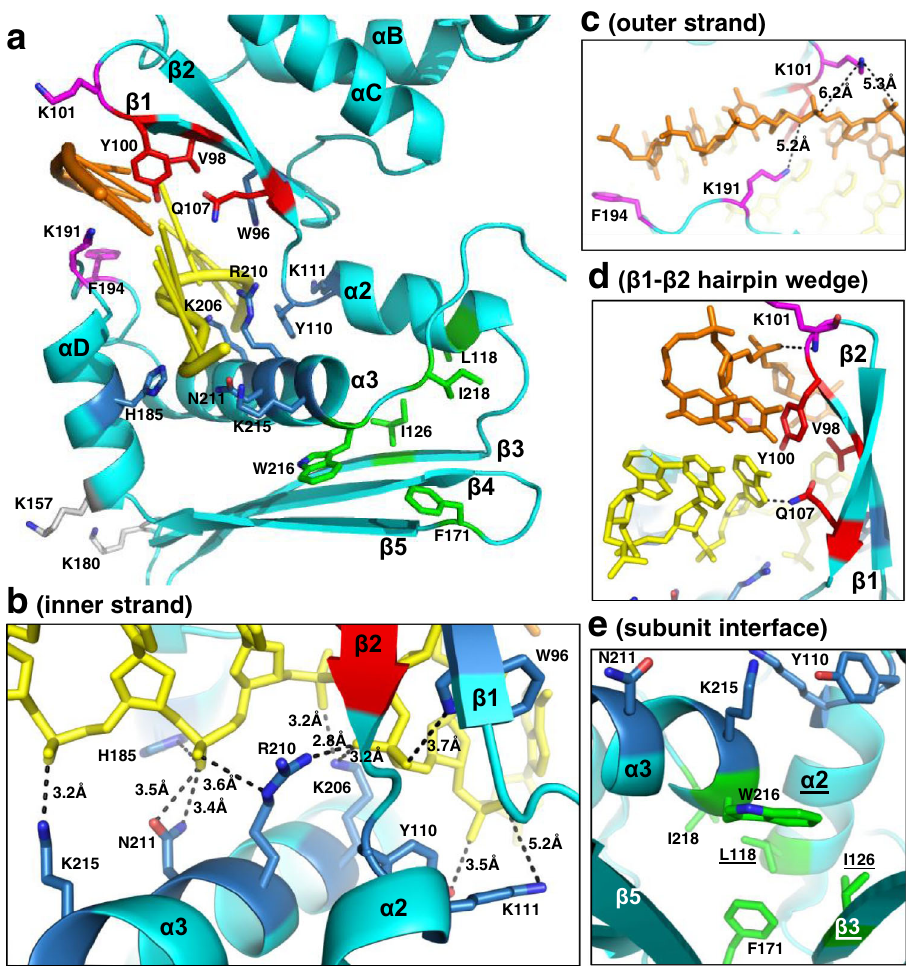
Fig. 7 | ResiduesofLiRecT targetedfor mutationalanalysis.a View of anLiRecT monomer with residues color-coded by location in the structure: blue for inner- strand binding, magenta for outer strand binding, red for β 1 – β 2 hairpin wedge, green for subunit-interface, and gray for control (no interactions). b – e Close-up views of the four different regions. Hydrogen bonds and ion pairs are shown in